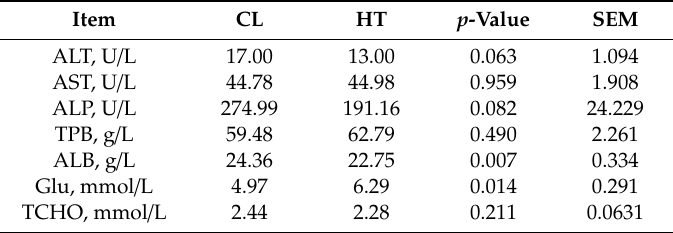
Figure 1. E ff ects of the temperature humidity index (THI) on the microtubule-associated protein 1 light chain 3-II (LC3-II) expression of the liver, kidney, duodenum, abomasum and rumen in the HT and CL calves. Treatment was as follows: (1) HT: Calves were fed from July 15 to August 19; (2) CL: Calves were fed from April 10 to May 15. Insets depict representative blots. Values represent means ± standard deviation Response from statistical result, p < 0.05. β -Actin was used to normalize the expression of target proteins. The letters below the bar graph indicate di ff erent organs. Di ff erent letters above the bar indicate di ff erences between di ff erent groups ( p < 0.05). Table 2. Serum concentrations of alanine aminotransferase (ALT), aspartate aminotransferase (AST), alkaline phosphatase (ALP), total protein (TP), albumin (ALB), glucose (Glu) and total cholesterol (TCHO) of the calves in the CL (cooling) and HT (heat stress)